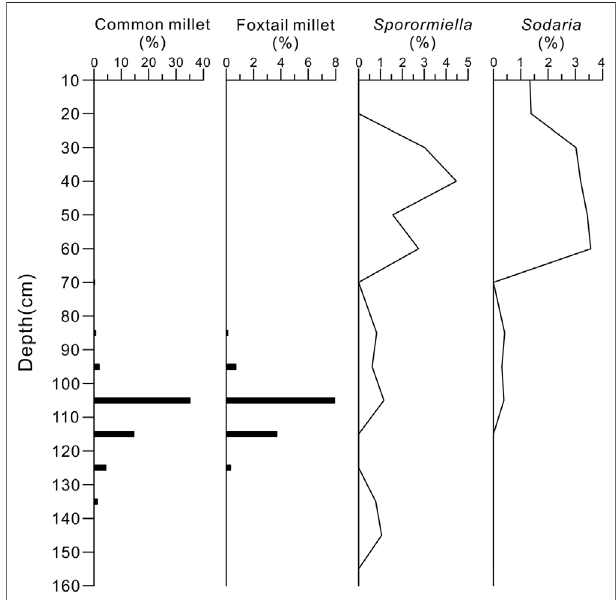
FIGURE 6 | Contents of common millet and foxtail millet phytoliths and fungal spores inthe ZKG section.